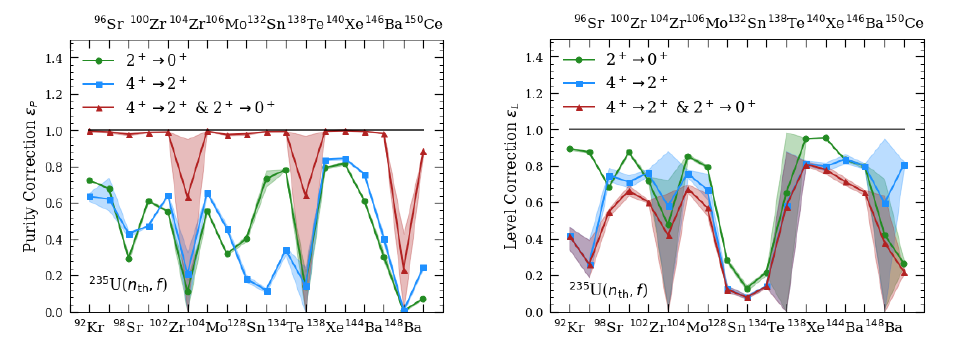
Figure 2. (Color online) Left plot shows the purity correction (cid:15) P , while the right plot shows the level correction (cid:15) L ratio for several even-Z even-A fission products. Circles (green) indicate the 2 + → 0 + transition, squares (blue) indicate the 4 + → 2 + transition, and triangles (red) indicate a double-gate on both. The curves and points signify the mean correction over the three CGMF calculations (see text). The bands show the upper and lower correction values, where bands that have a lower bound of zero indicate that the particular γ -ray transition did not exist in the default RIPL-3 database.